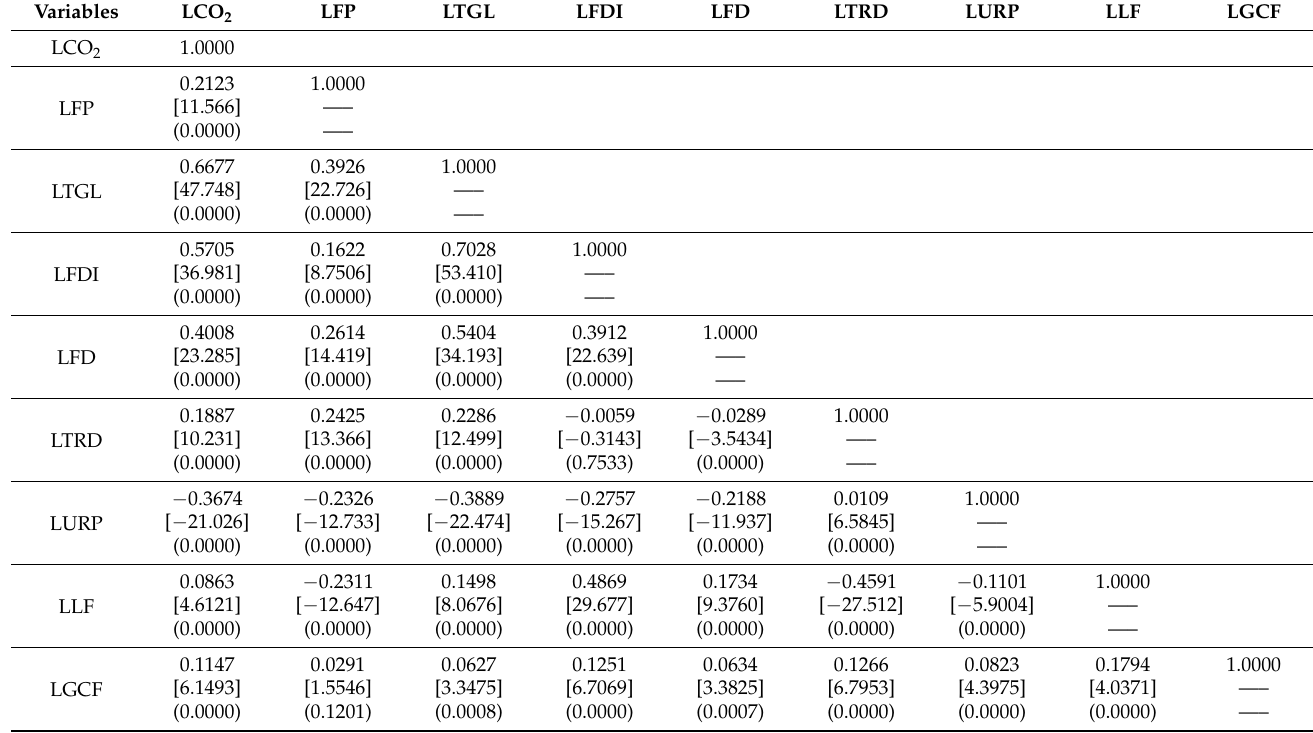
Table 4. Correlation matrix.